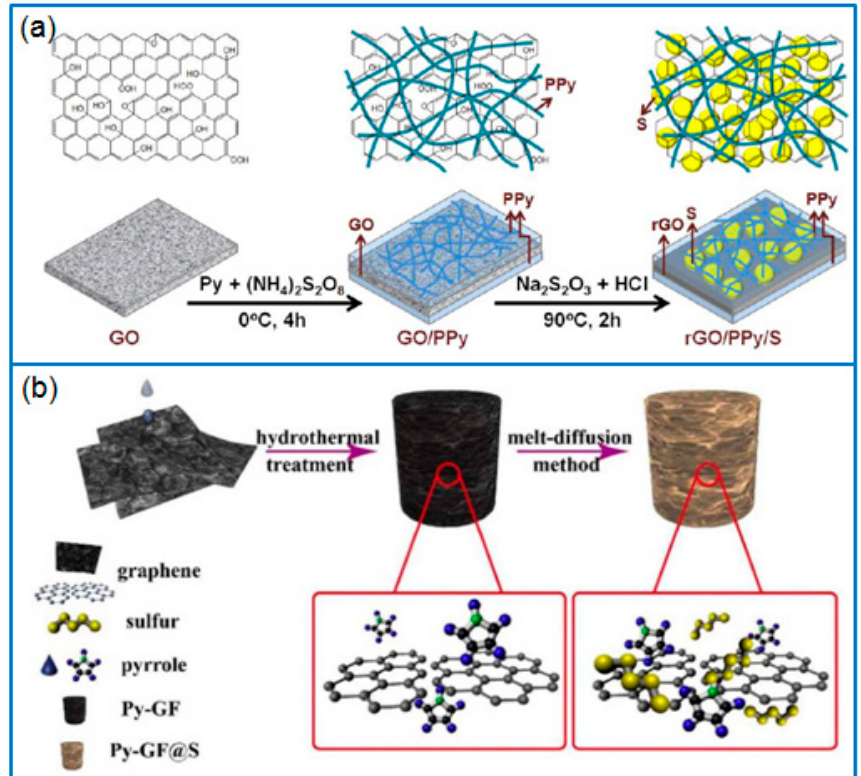
Figure 5. Schematic of preparing ( a ) rGO/PPy/S nanocomposite [75] and ( b ) pyrrole modified graphene aerogel foam (Py-GF) for Li-S batteries [77].